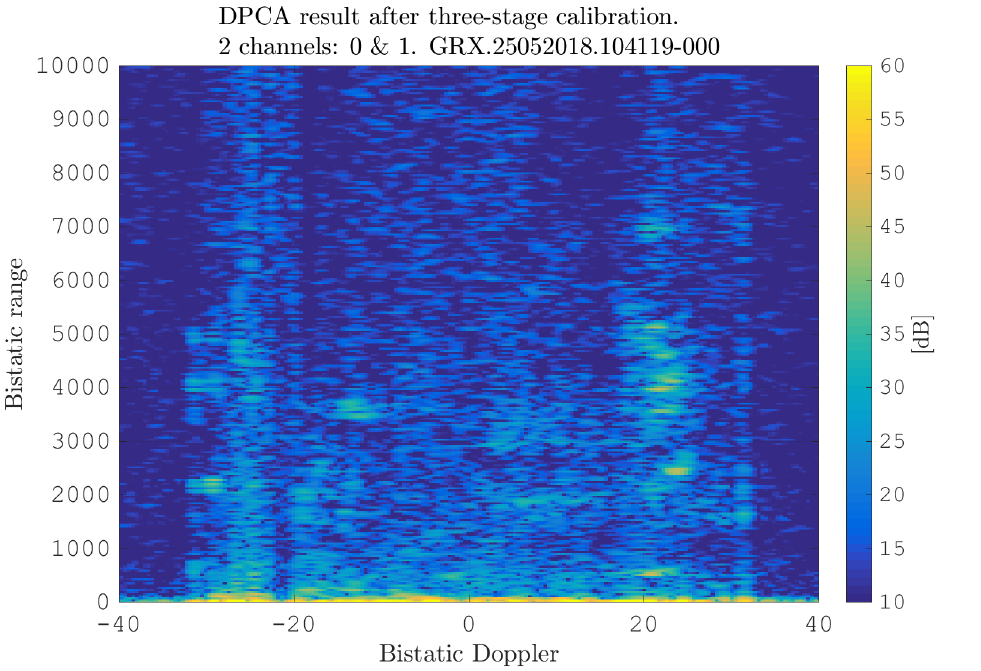
Figure 19. Range-Doppler map after calibrations using CDS and MVPS and clutter suppression using